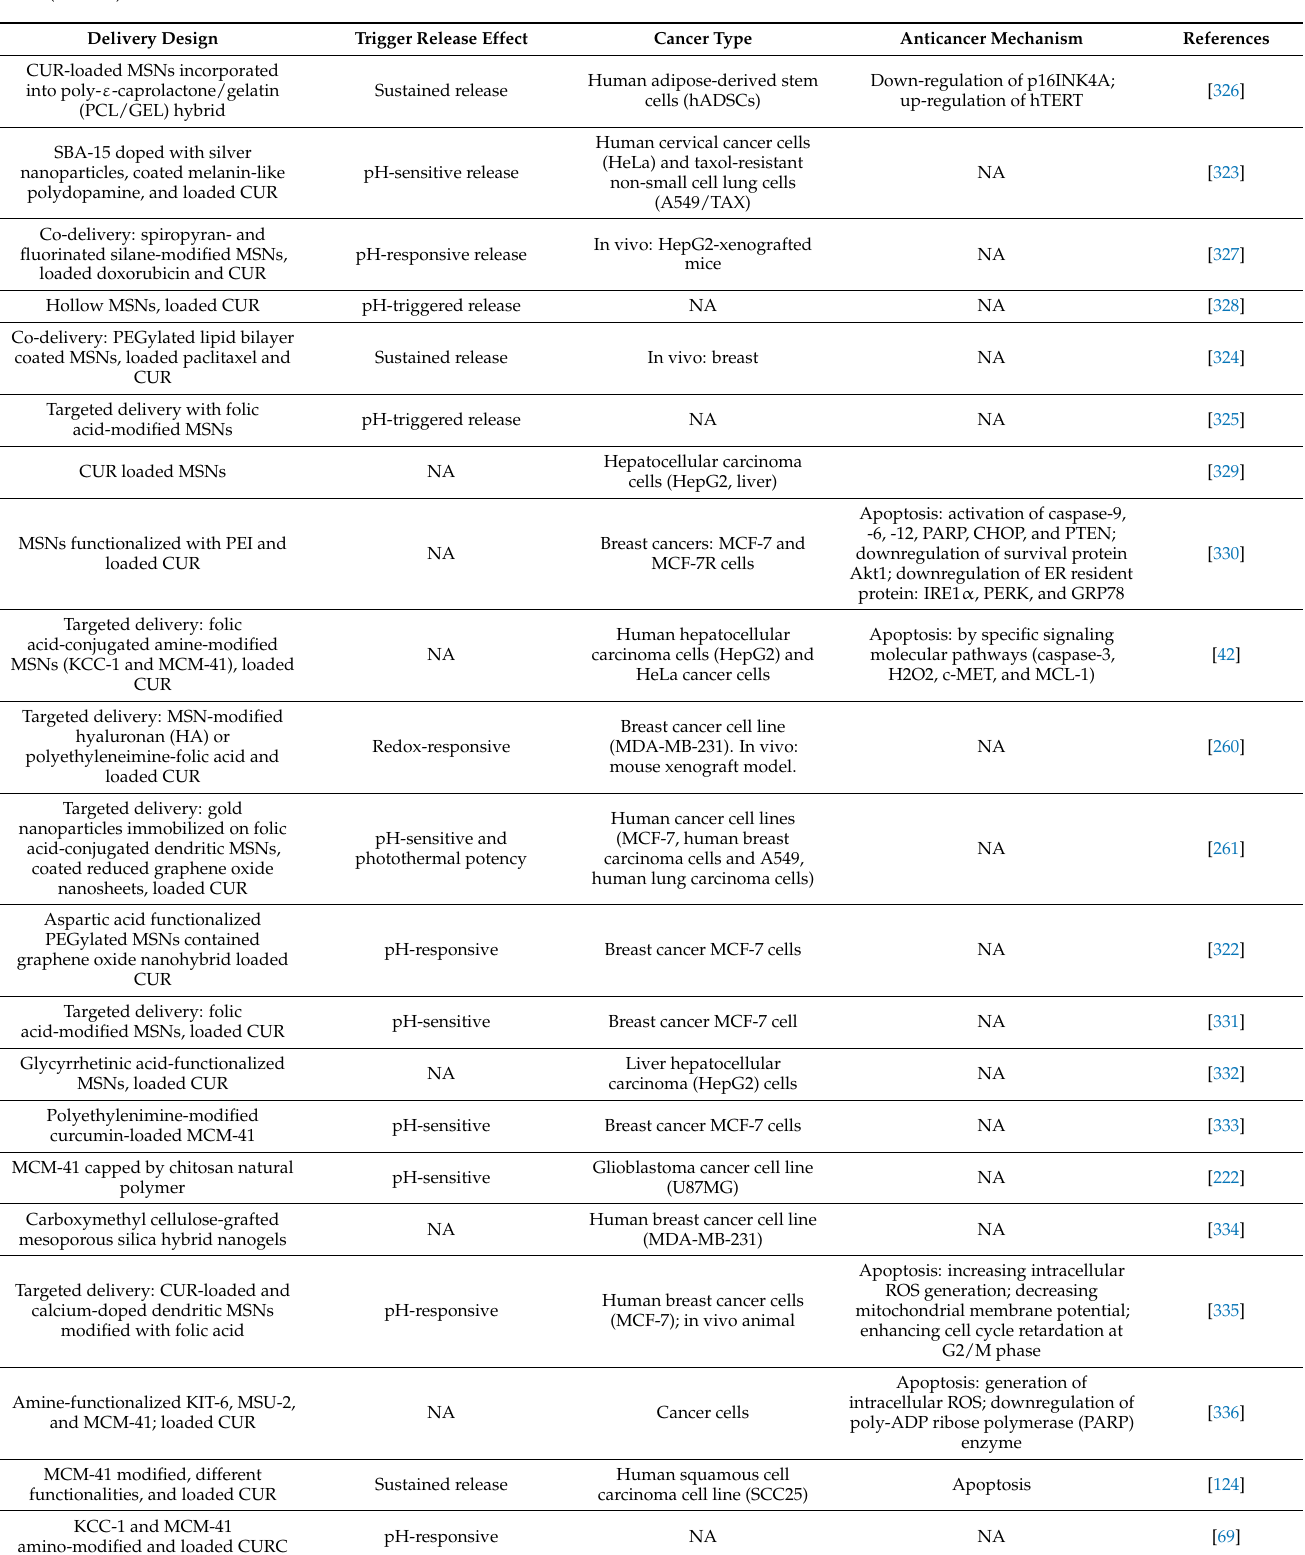
Table 8. Delivery designs for curcumin in cancer (in vitro/in vivo studies) based on mesoporous silica nanoparticles